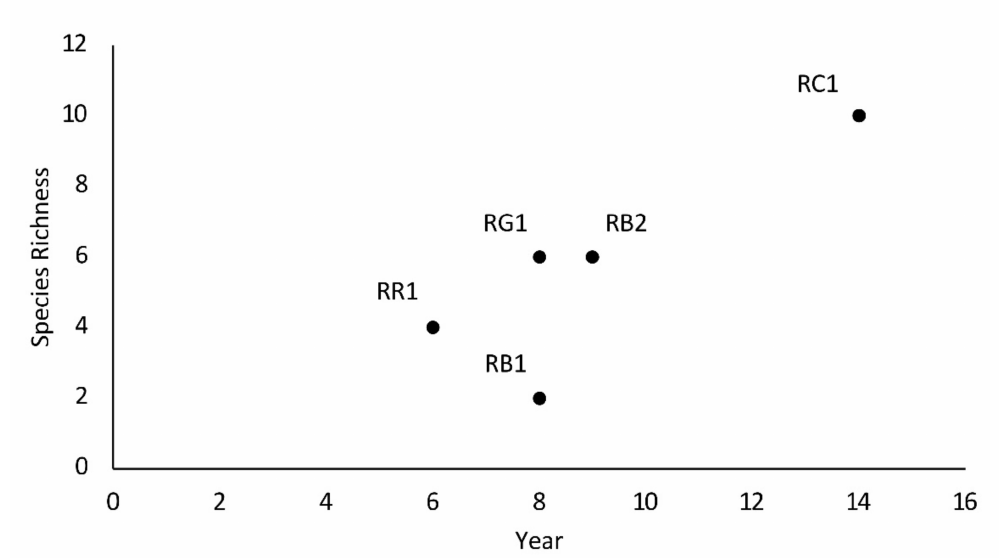
Figure 5. Linear regression of mussel species richness by number of years since dam removal in the Lake Michigan basin, Michigan,